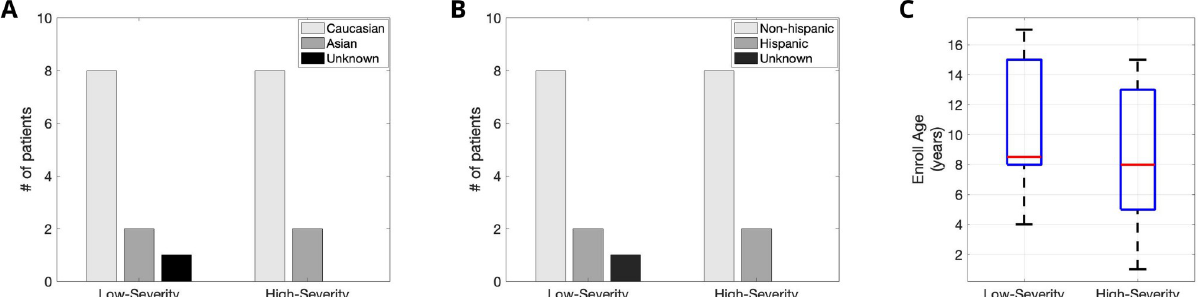
Fig 2. The race, ethnic and age split in the cohort. (A) We illustrate the number of patients in each of the caucasian, asian and unknown races in both Rett severity groups. (B) We illustrate the number of patients in each of the non-hispanic, hispanic and unknown ethnicities in both Rett severity groups. (C) We depict a box plot created with the ages of the patients in the two Rett severity groups, showing the median, 25 th percentile and the 75 th percentile.